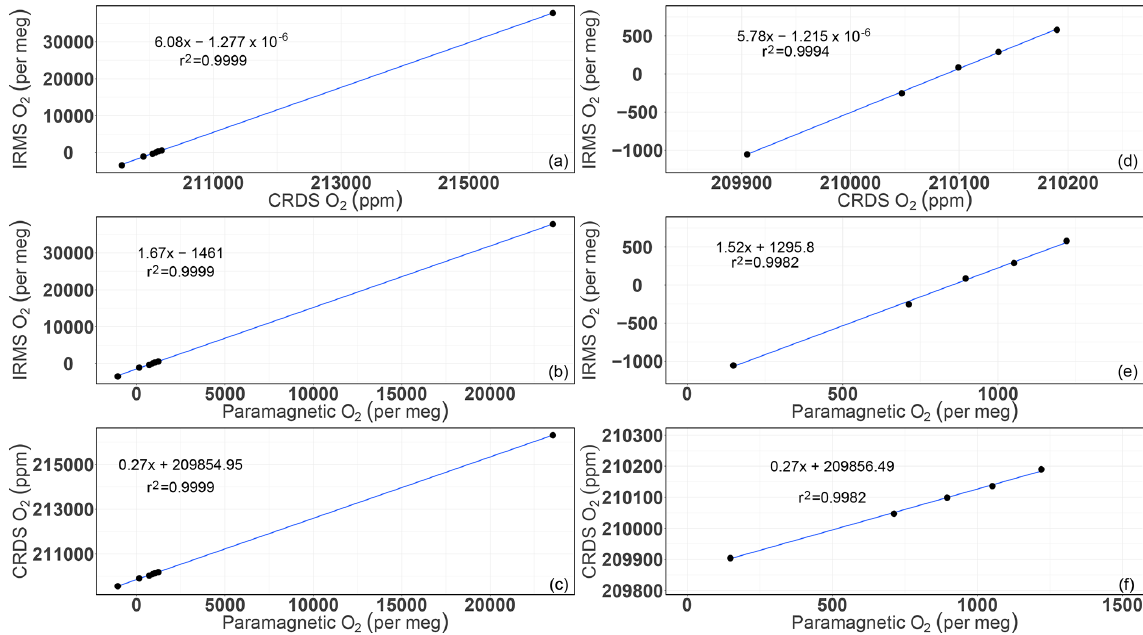
Figure A1. Correlations of the O 2 mixing ratios measured by the CRDS and paramagnetic analyzers with the mass spectrometric measure- ments (uncalibrated values). Panels (a) , (b) , and (c) are for all of the cylinders measured (standards 1 to 8), whereas panels (d) , (e) , and (f) are after selecting standards 1–5.